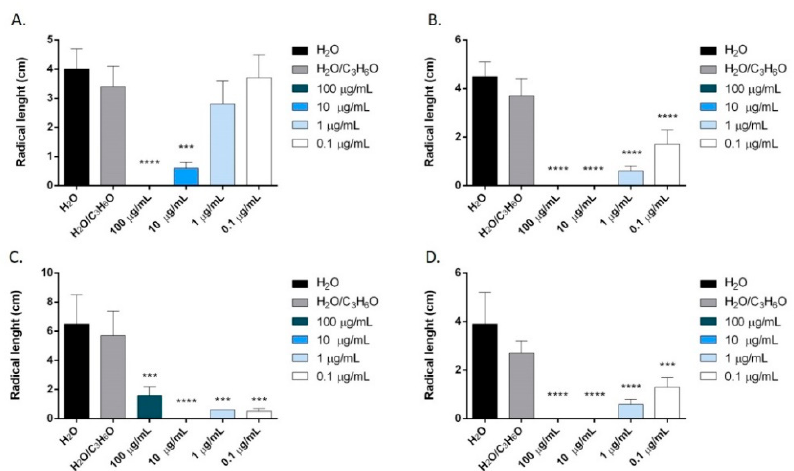
Figure 12. Phytotoxic activity of terpinen-4-ol against radical elongation of L. sativa ( A ), L. sativum ( B ), S. lycopersicum ( C ), R. sativum ( D ). Results are expressed as the mean of three experiments standard deviation. *** p < 0.001, **** p < 0.0001 compared to control (ANOVA followed by Dunnett’s multiple comparison test).